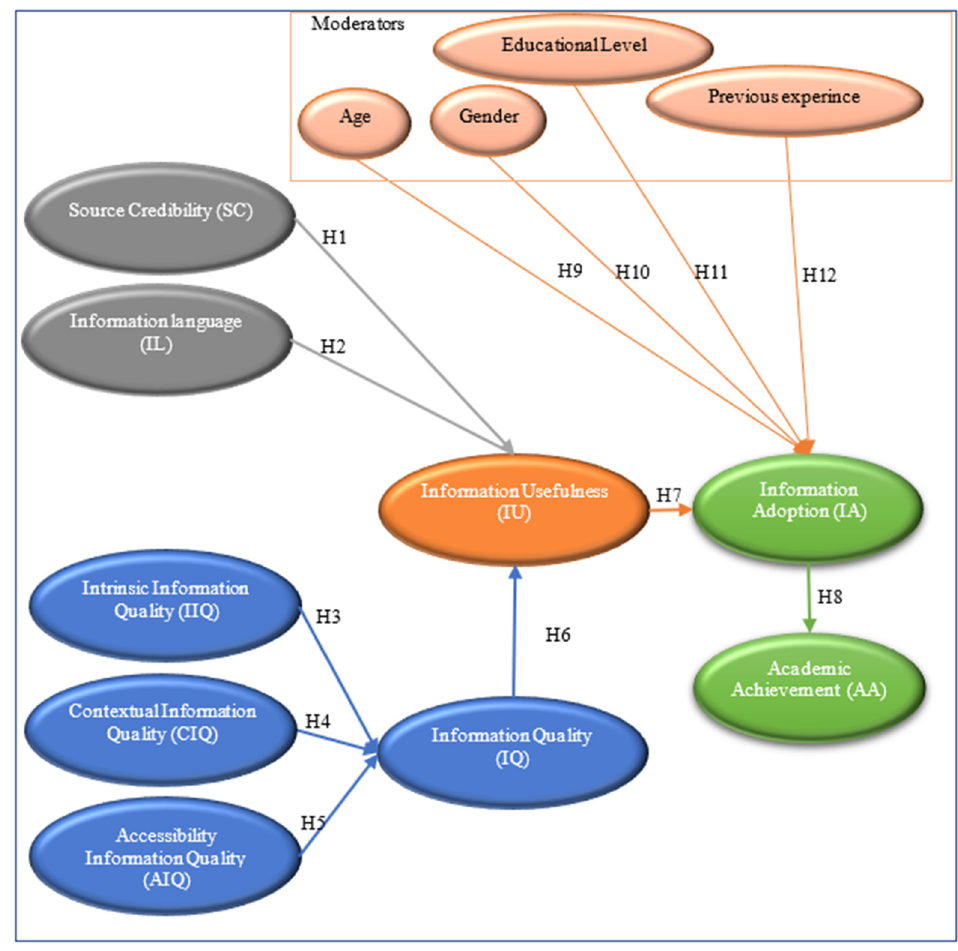
Figure 1. Proposed model based on expanded IAM.